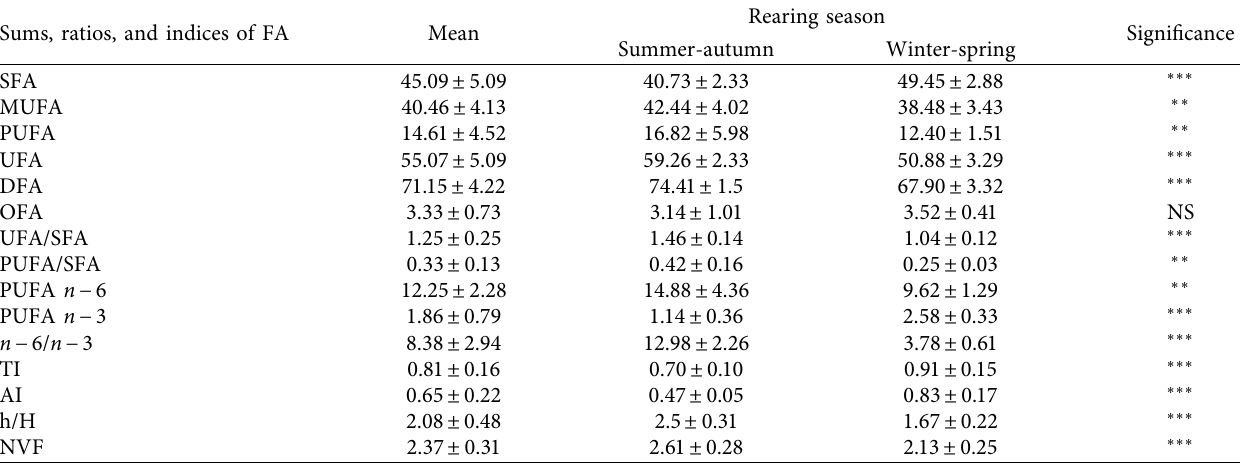
Table 3: Rearing season effect on the sums, ratios, and indices of fatty acids profile of Beni-Guil sheep breed. Sums, ratios, and indices of